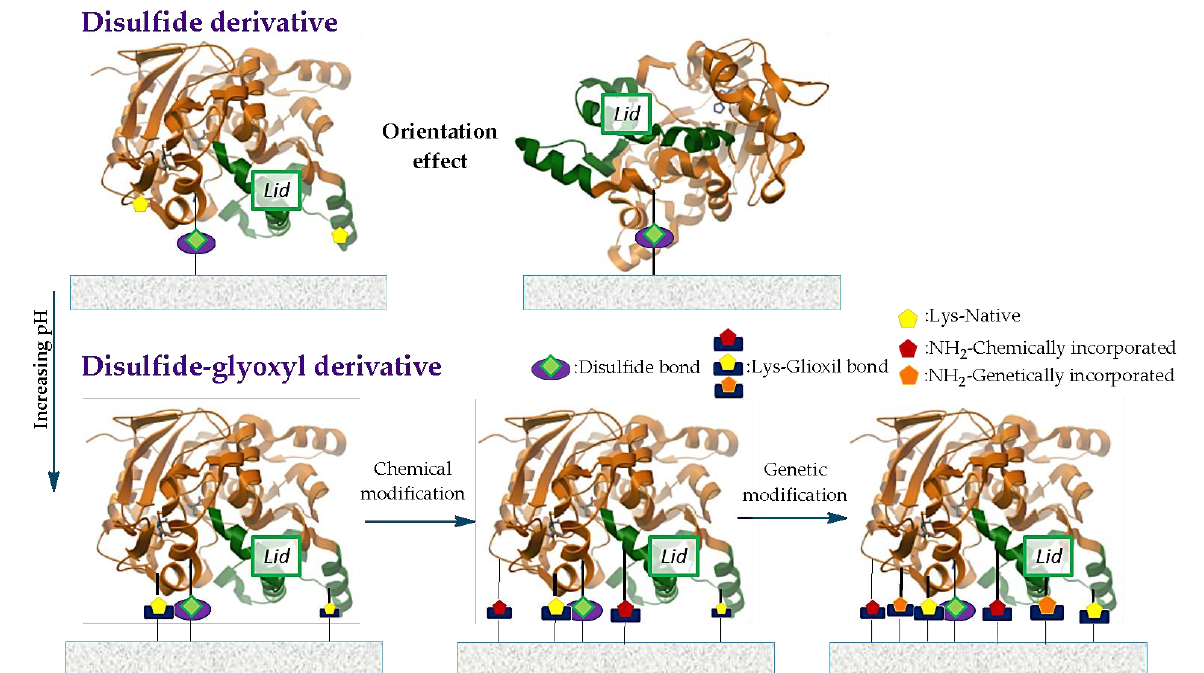
Figure 9. Control of enzyme orientation and binding intensity in glyoxyl/disulfide supports. Disul- fide bonds are produced using Cys (Green) residues (introduced by site-directed mutagenesis) allowing oriented enzymatic immobilization in disulfide and glyoxyl-disulfide supports at pH 7.0. In addition, if after that the pH is increased glyoxyl groups (blue) will react with the Lys-native residues (yellow). On the other hand, the bonding degree can be increased by incorporating new anchor groups (NH 2 ) through: (i) Chemical modification: addition reactions of EDA (ethylenediamine) to the carboxylate groups of the Asp and Glu residues. (ii) Genetic modification: changes in the protein sequence from Arg to Lys residues introduced by site-directed mutagenesis. All the above allows achieving control of the orientation and degree of binding of the